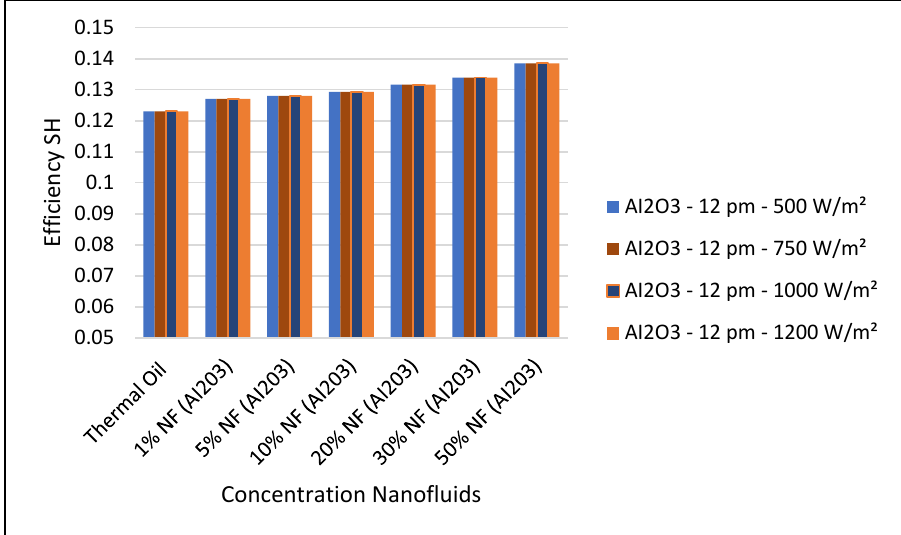
Figure 24. CSP system hybrid efficiency at different concentrations of Al 2 O 3 and solar radiations.